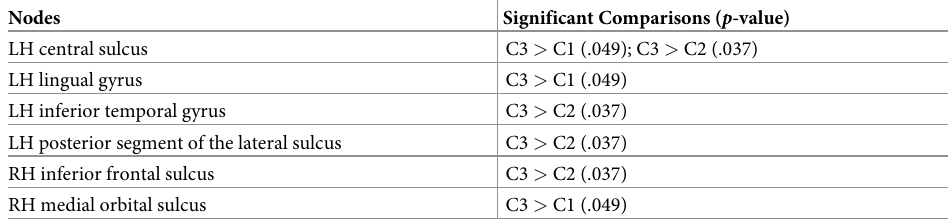
Table 3. Cortical thickness network nodes with altered